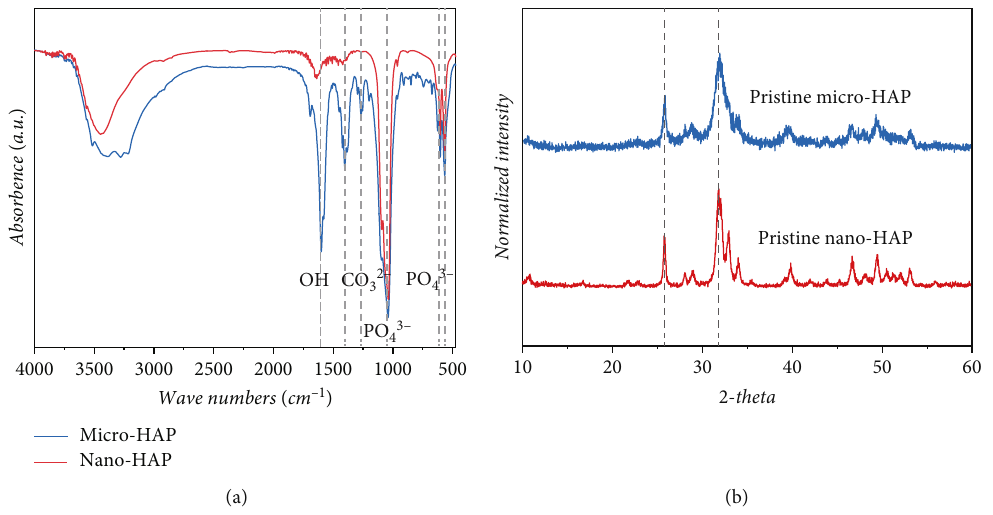
Figure 2: FTIR spectrum (a) and XRD pattern (b) of micro-HAP and nano-HAP.